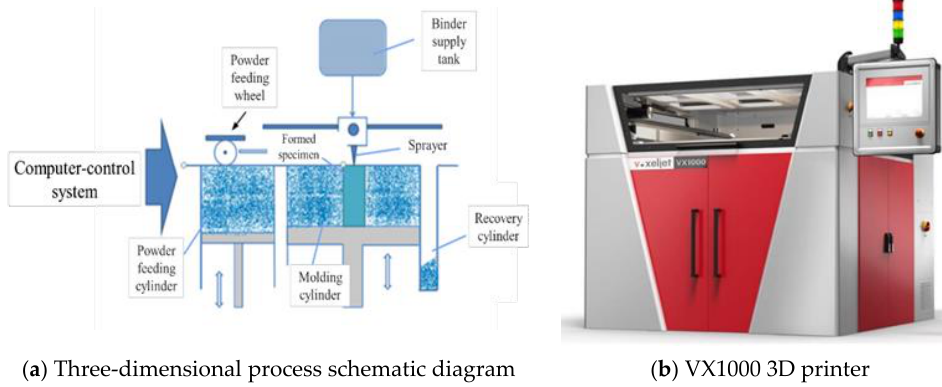
Figure 2. Working principle and equipment of 3D printing process [33].